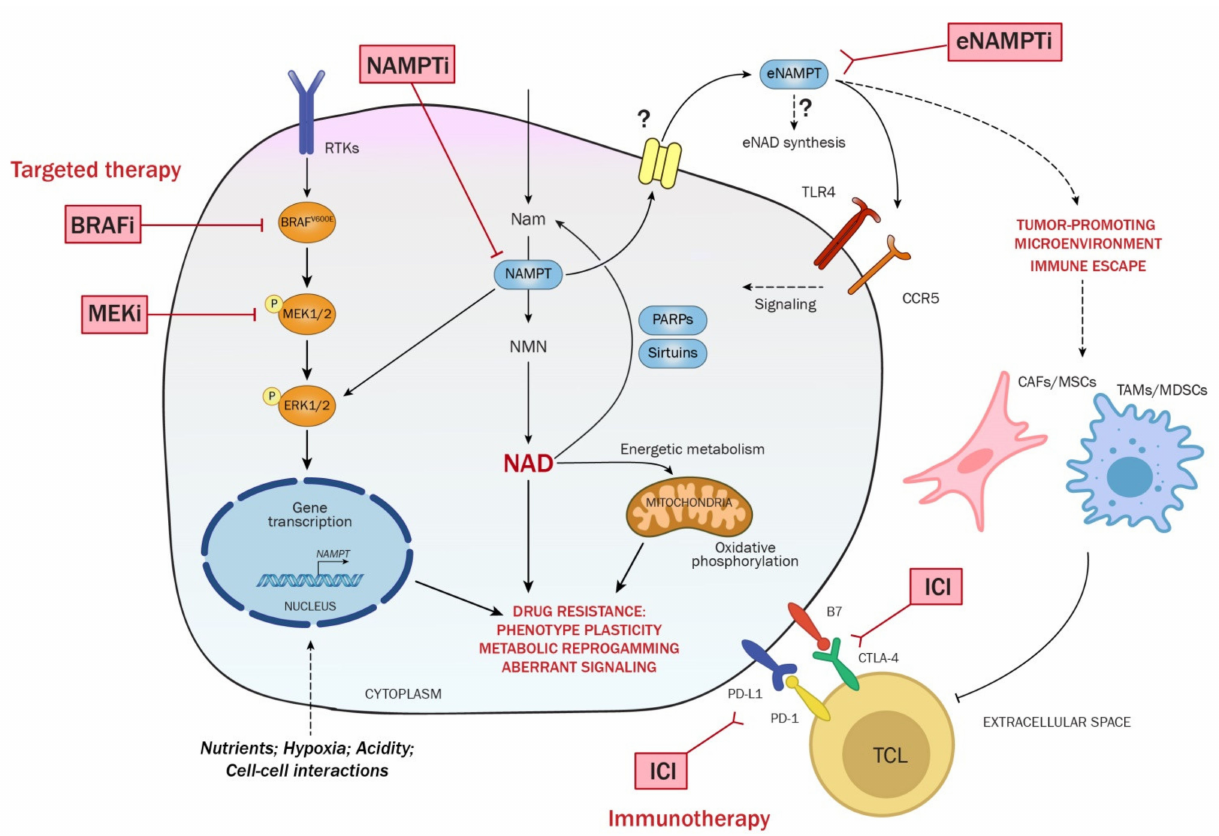
Figure 2. Summary of the cellular processes regulated by NAD/NAMPT axis and its connections with the BRAF/MEK/ERK signaling cascade. NAMPT is the rate-limiting enzyme in NAD biosynthe- sis starting from nicotinamide (Nam) that, in turn, is released by NAD-consuming enzymes (PARPs and Sirtuins mainly involved in DNA repair and epigenetics). The BRAF oncogenic signaling and NAMPT/NAD pathway are connected in melanoma: the activation of BRAF-mutated pathway promotes NAMPT transcription and NAD metabolism; on the other hand, NAMPT overexpression support MAPK activation in a positive loop. Increased levels of NAMPT and NAD sustains energetic metabolism and drives drug resistance mechanisms. NAMPT can be also released by melanoma cells, through unknown mechanisms, acting as cytokine binding to TLR4 and/or CCR5 and trig- gering intracellular signaling. In the microenvironment of melanoma the function of eNAMPT has not been well established, however, in other tumor models it can create immunosuppressive and tumor-promoting conditions modulating immune responses. Note that NAMPT inhibition (using pharmacological agents and/or neutralizing antibody) can play a role in blocking melanoma growth and progression, counteracting BRAF inhibitors resistance and impacting on tumor microenviron- ment. i: inhibitors; ICI: immune checkpoint inhibitors; NMN: nicotinamide mononucleotide; TLR4: Toll-like receptor 4; CCR5: C–C chemokine receptor type 5; TCL: T cytotoxic lymphocyte; CAFs: cancer-associated fibroblasts; MSCs: mesenchymal stem cell; TAMs: tumor-associated macrophages; MDSCs: myeloid-derived suppressor